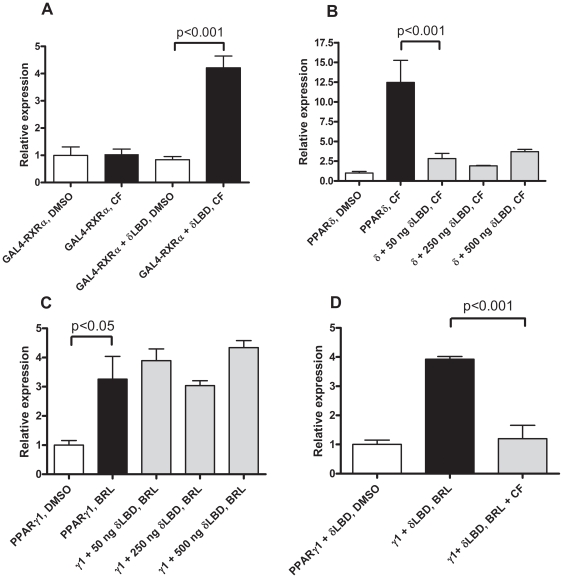
(A) The PPARδ LBD is functional with respect to transcriptional transactivation and RXR heterodimerisation and (B), (C) and (D) possess ligand-dependent dominant negative behaviour.(A) COS-1 cells were transfected with 500 ng pCMVgRXR and 500 ng pCLDN or pCLDN-δLBD. (B), (C) and (D) COS-1 cells were transiently transfected with: (B) 500 ng pJ3Nuc (hPPARδ expression plasmid) and 0 to 500 ng pCLDN or pCLDN-δLBD; (C) 50 ng pCLDN-hPPARγ1 and 0 to 500 ng pCLDN or pCLDN-δLBD; (D) 50 ng pCLDN-hPPARγ1 and 500 ng pCLDN-δLBD.